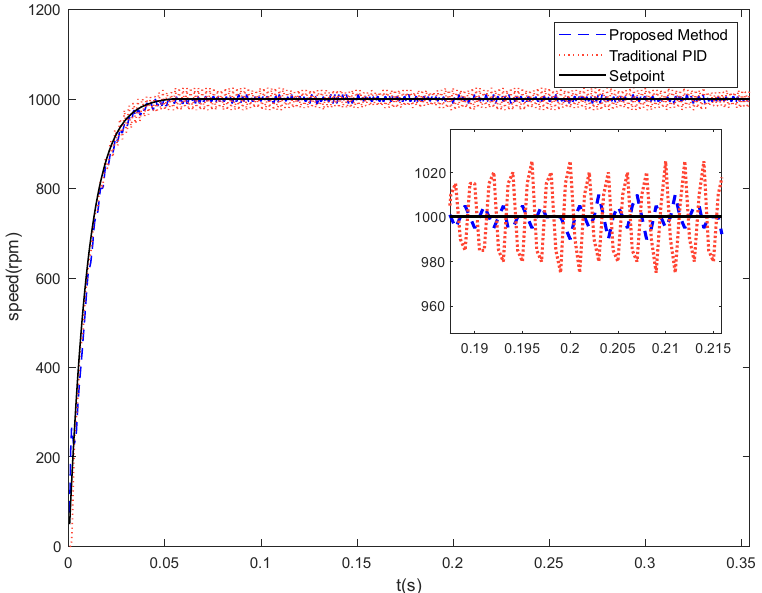
Figure 20. Actual operation effect of traditional PID and proposed method.